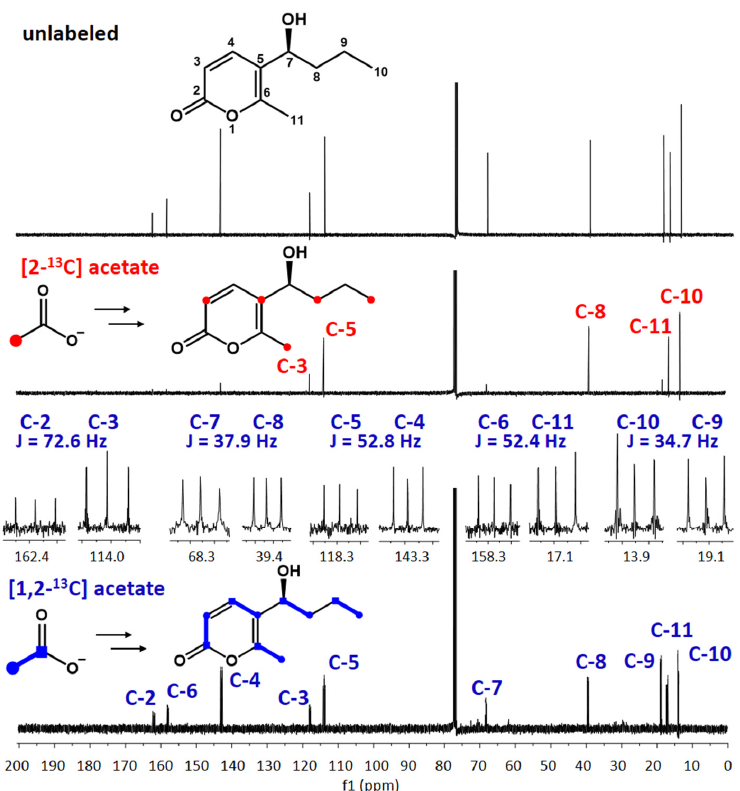
Figure 3. 13 C-NMR spectra of xylariolide D ( 1 ) without and with 13 C-labeled acetate.